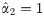
ATP production vs. substrate limits with low cost respiration.α1 = 1, α2 = 1, α3 = 10, Γ = 200, α^2=1 and v1 is capped by a value within the range [0, +∞). When the uptake of the substrate has a limit greater than 18.18, it will not affect the ATP production and it remains as 581.8. As shrinking the constraint, the ATP production rate is linearly decreased until 545.4 when there is no net external substrate provided. The turning point is at (18.18, 581.8).